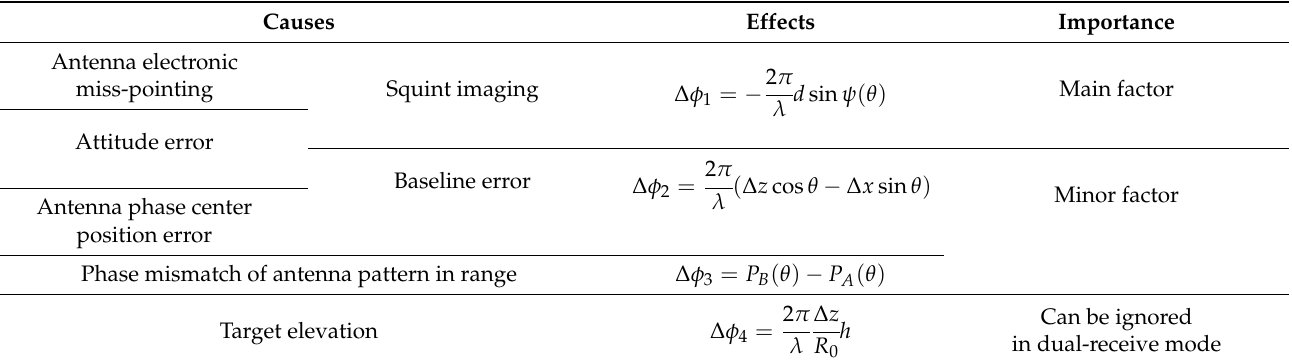
Table 7. Causes of the space-varying of the phase imbalance in GF-3 ATI mode. Causes Effects